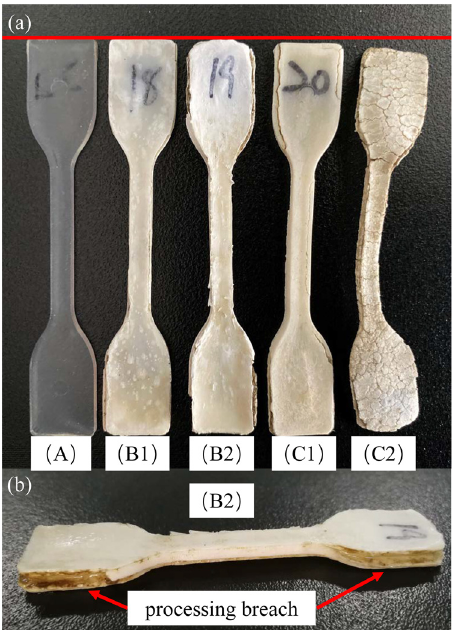
Figure 3: ( a ) Surface morphology after degradation. The letters A, B, and C represent PLA, PVA0588/PLA, and PVA1788/PLA, respectively; The numbers 1 and 2 represent the mass ratios of PVA/PLA: 30/70 and 50/50, respectively. ( b ) Side view of PVA0588/PLA = 50/50 specimens ( B2 )